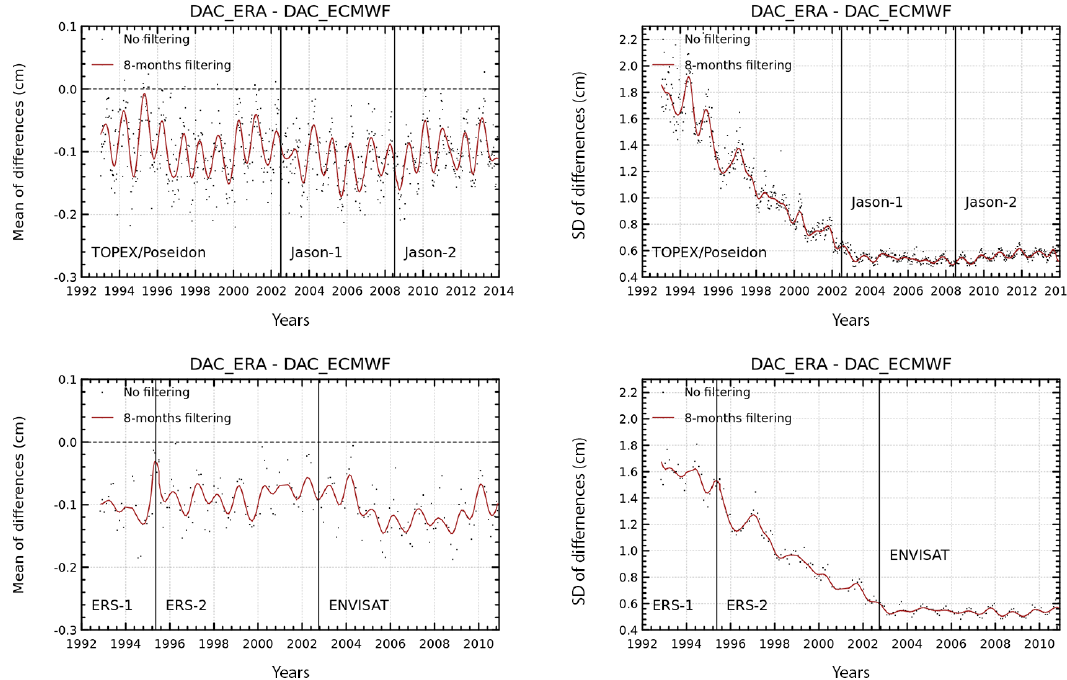
Figure 3. Temporal evolution of the global differences between DAC_ERA and the operational DAC seen by each altimeter mission: TP, Jason-1, and Jason-2 (top), and ERS-1, ERS-2, and Envisat (bottom) (mean and standard deviation in